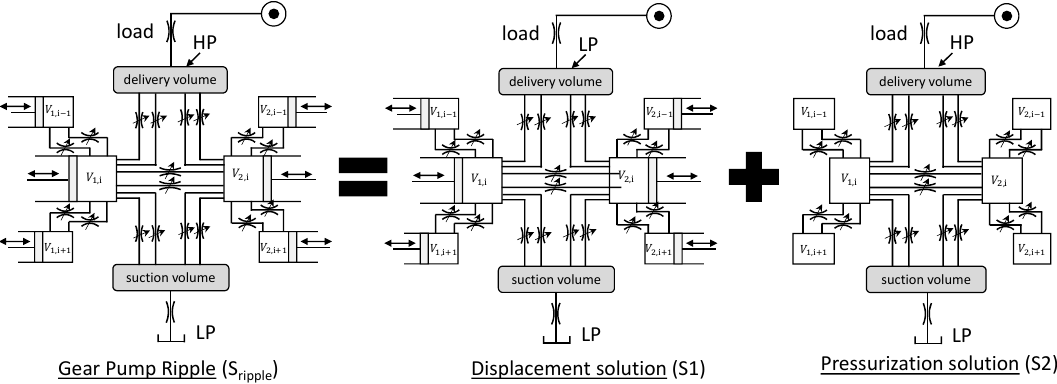
Figure 8. The overall lumped-parameter model circuit and two decoupled circuits. The decoupled circuits can reproduce the displacement solution (S1) and the pressurization solution (S2)